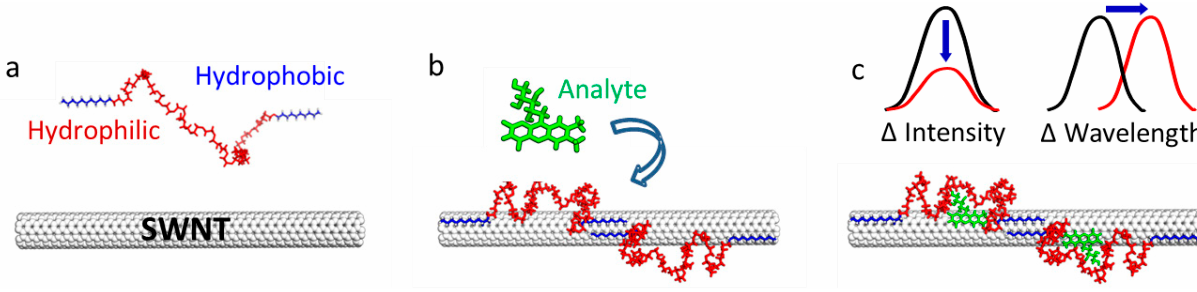
Figure 2. Principle of CoPhMoRe. ( a ) A polymer with hydrophobic and hydrophilic parts adopts a specific conformation when ( b ) adsorbed to the nanotube, thereby enabling analyte-specific binding. ( c ) Selective analyte binding leads to a wavelength or intensity change in SWCNT fluorescence (with permission from